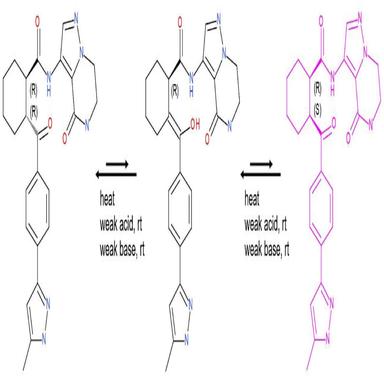
AZD5718 keto-enol equilibrium and epimerization.